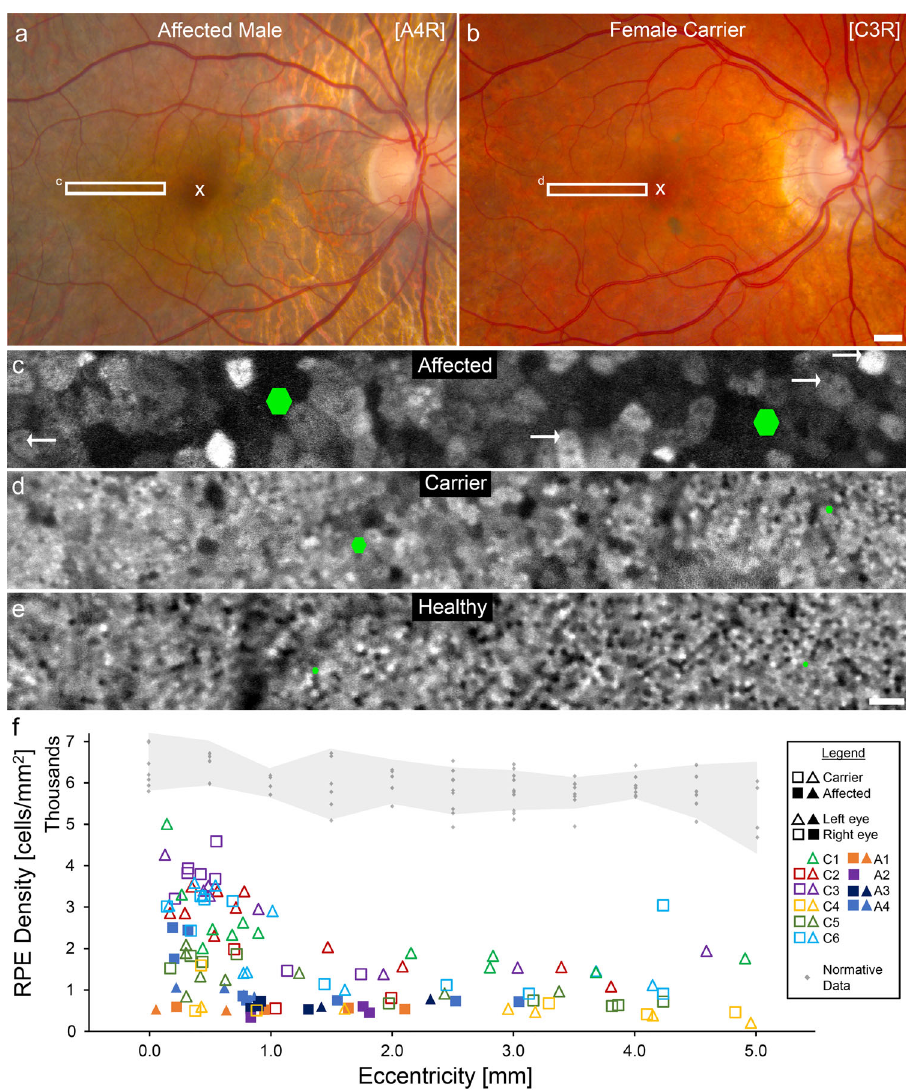
Fig. 1 Enlarged retinal pigment epithelial (RPE) cells observed in choroideremia. a , b Color fundus images of an affected male and a female carrier showing areas of outer retinal atrophy and mild pigmentary changes, respectively. The white ‘ x ’ denotes the fovea (eccentricity = 0.0 mm). Subject codes are shown in brackets (L = left eye, R = right eye; A = affected male, C = female carrier). The number in the brackets refers to the subject number (Supplementary Table 1). White rectangles indicate areas where high resolution adaptive optics (AO) images were obtained. Scale bar, 1 mm. c , d Late phase adaptive optics enhanced indocyanine green (AO-ICG) images of the RPE mosaic obtained in the white rectangles from ( a and b ). e For comparison, an AO-ICG image obtained from a similar area in a healthy right eye is shown. Green hexagons denote the approximate size of single RPE cells in the immediate vicinity of the hexagon (barely visible in the healthy eyes). The nuclei of RPE cells are visible in some of the enlarged cells (arrows point to examples of nuclei visible as hypo fl uorescent spots). In the healthy eye, RPE cell size is nearly constant across the image; in contrast, the RPE cells in the carrier eye are variable in size, with many of the cells enlarged. The RPE cells in the affected eye are consistently enlarged across the entire image. Scale bar for ( c – e ), 100 µ m. f Quantitative measurements of RPE cell density obtained at different locations (eccentricities) from the fovea out to ~5.0 mm in the temporal direction (female carriers, un fi lled symbols; affected males, fi lled symbols; triangles, left eye; squares, right eye). Measurements of RPE cell density in the affected eyes were possible only up to the edge of atrophy, which was generally <3.0 mm. RPE density in all subjects was signi fi cantly